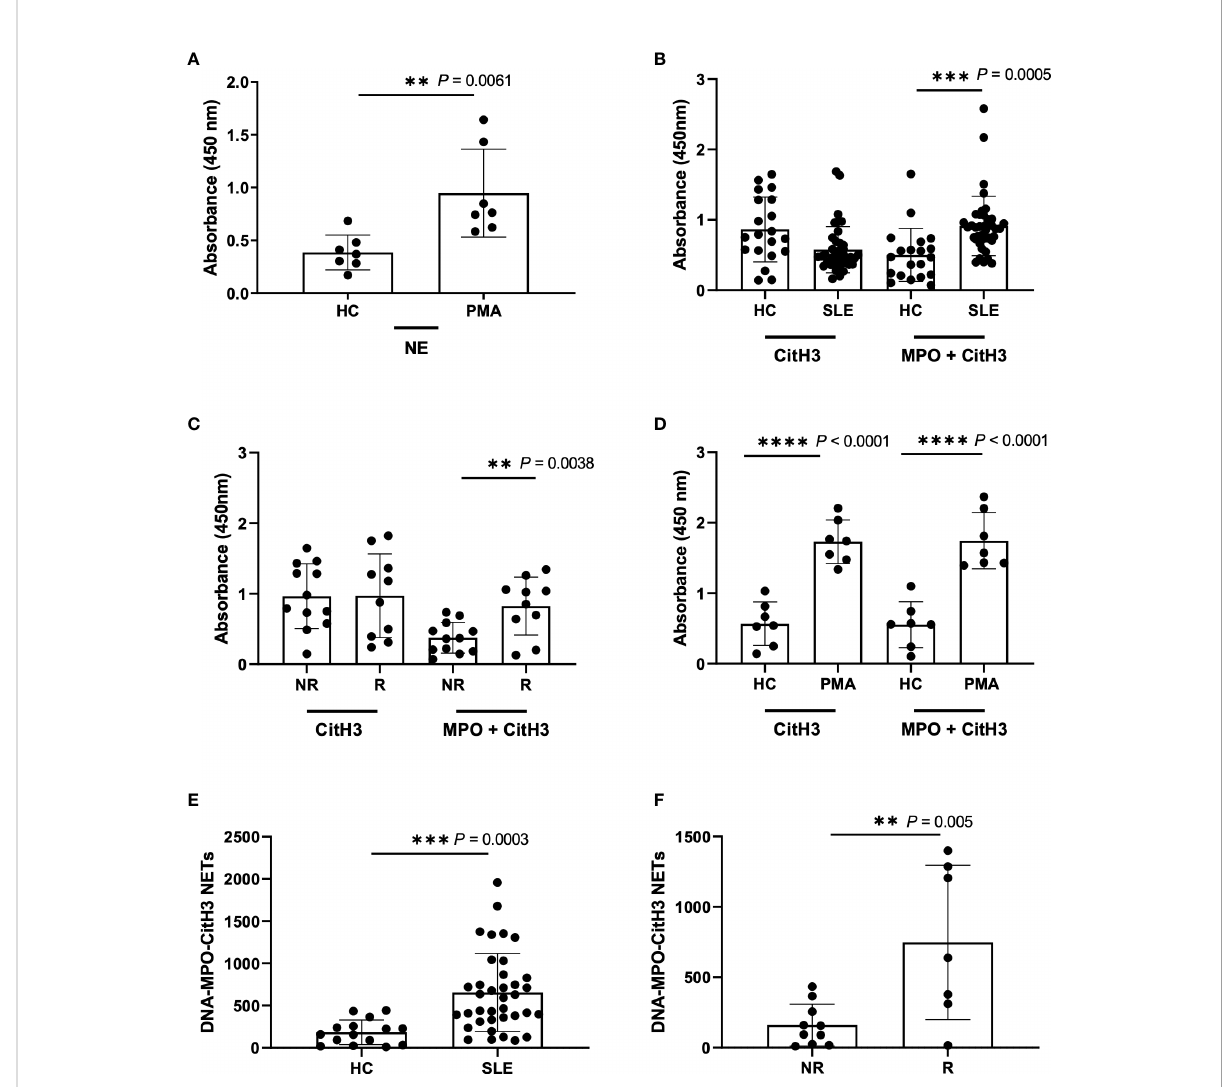
FIGURE 2 Detection of NETs using different ELISA methodologies with plasma samples from Healthy donors, PMA stimulated donors, SLE patient, and non-risk and risk GaP patient samples. (A) ELISA plate coated with 5µg/ml NE (SantaCruz) antibody using Healthy (HC) and PMA stimulated plasma samples (n=7). (B) ELISA plates were coated with CitH3 antibody (Abcam) or combination of MPO (Abcam) and CitH3 (Abcam) antibodies at a concentration of 5µg/ml to test healthy donors (n=20) against SLE patient donors (n=40), (C) non-risk (n=12) and risk (n=10) associated samples from the Genotype and Phenotype registry, and (D) healthy donor against PMA stimulated plasma samples (n=7). ELISA was blocked using additional 5%NRS in the buffer and developed using TMB substrate and results demonstrate differences in plate absorbance values in the presence and absence of MPO (Abcam) in the initial antibody coating (B-D) . (E) Extrapolated data from standard curve to represent DNA-MPO-CitH3 NET content in healthy controls (n=15) and SLE (n=37) and (F) GaP non-risk (n=10) and risk (n=7) samples using data from MPO+CitH3+DNA ELISA. Single data points represent individual donors. Plotted data are after background subtraction. Data are presented as mean ± SD. P values are reported after unpaired parametric T test was performed. **<0.01; ***<0.001;